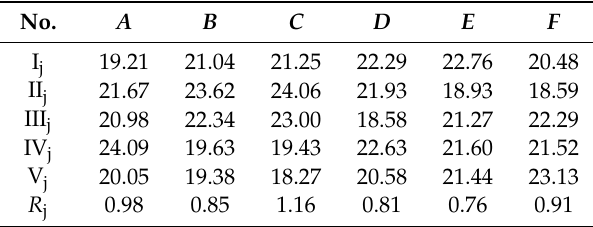
Table 5. Data table of density range analysis (density / g / cm 3 ).